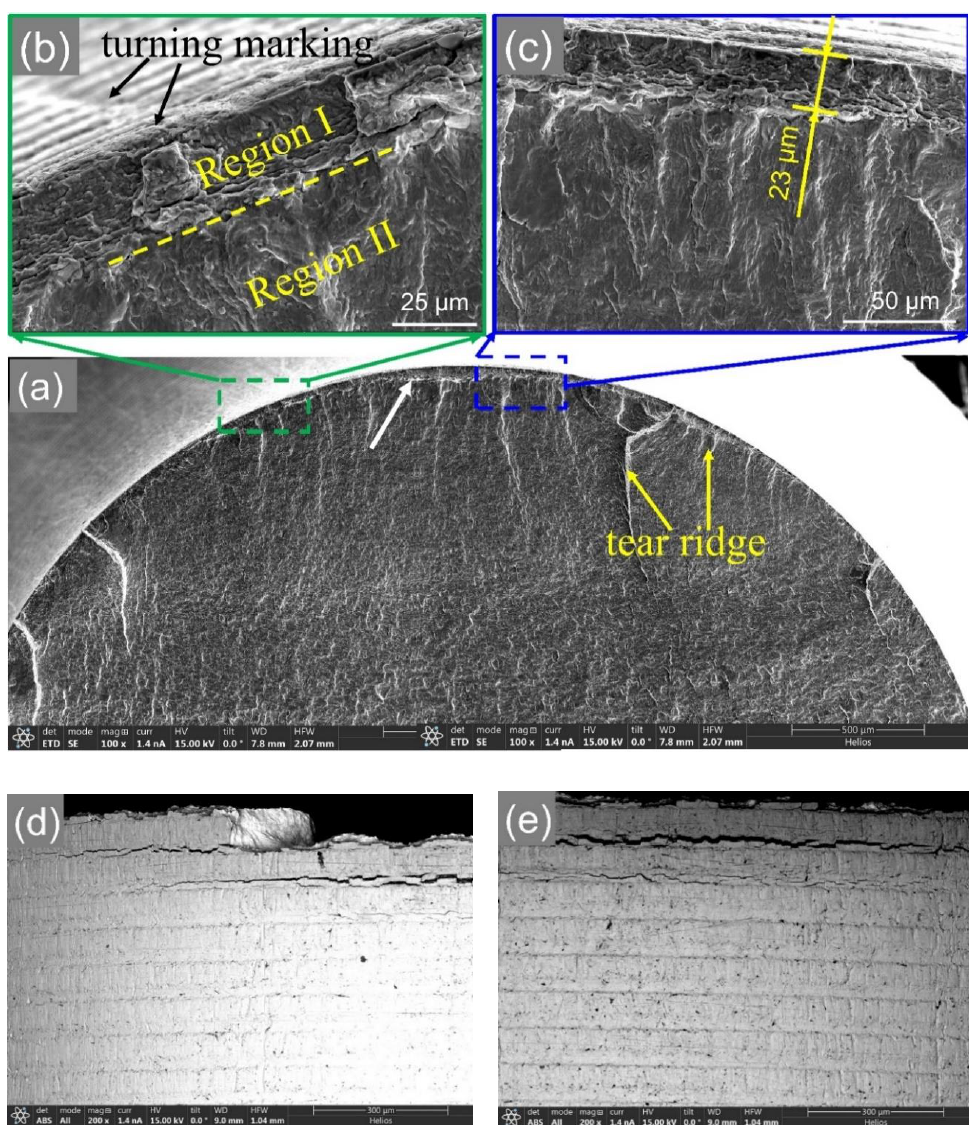
Figure 11. Fracture surface and surface morphology of a turned sample tested at σ a = 640 MPa and failed after N f = 3.29 × 10 8 cycles in the VHCF regime: ( a ) fracture morphology of the surface crack initiation area, ( b , c ) magnified image of the local crack feature on the surface, ( d , e ) several cracks along turning marks below the crack initiation site on the turned sample surface. The VHCF crack initiation and propagation scenario described above depends on the applied stress amplitude and the sample state including surface roughness, turning marks and residual stress induced by the turning process. These elements will be discussed in the next section.